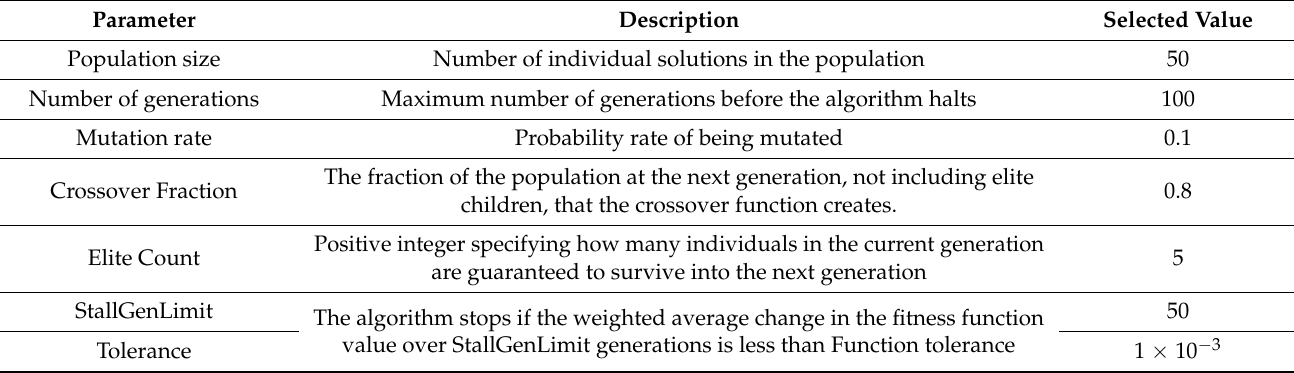
Figure 4. Proposed mechanism for estimating the fitness of each chromosome within a generation. Table 2. Hyperparameters of the optimized GenWrapper algorithm. A brief description of each hyperparameter is provided along with the finally selected